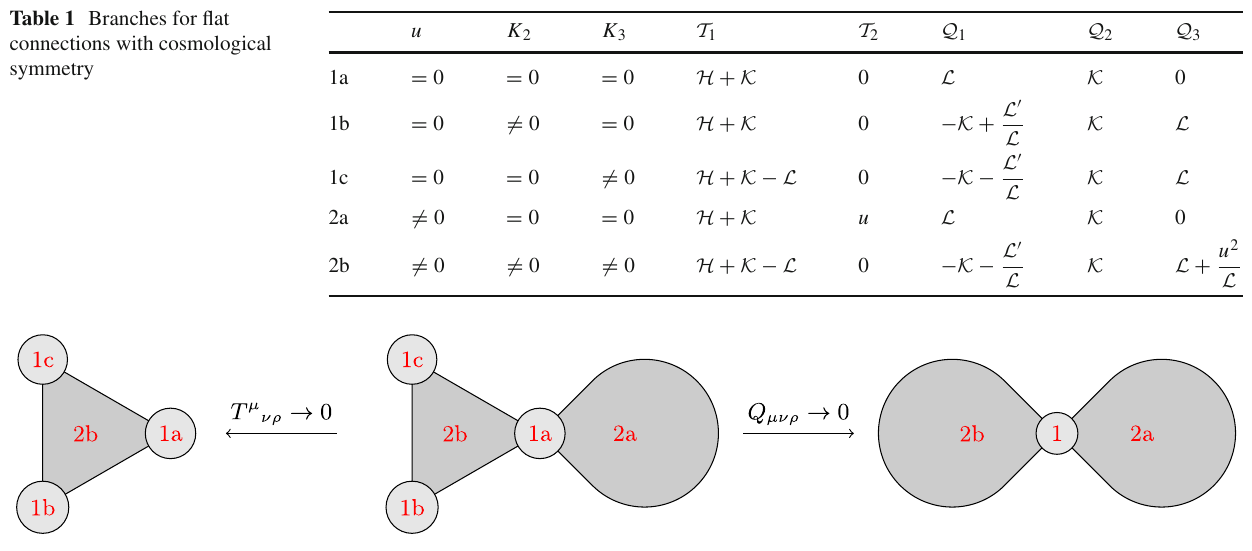
Fig. 1 Schematic relation between different cosmologically symmetric